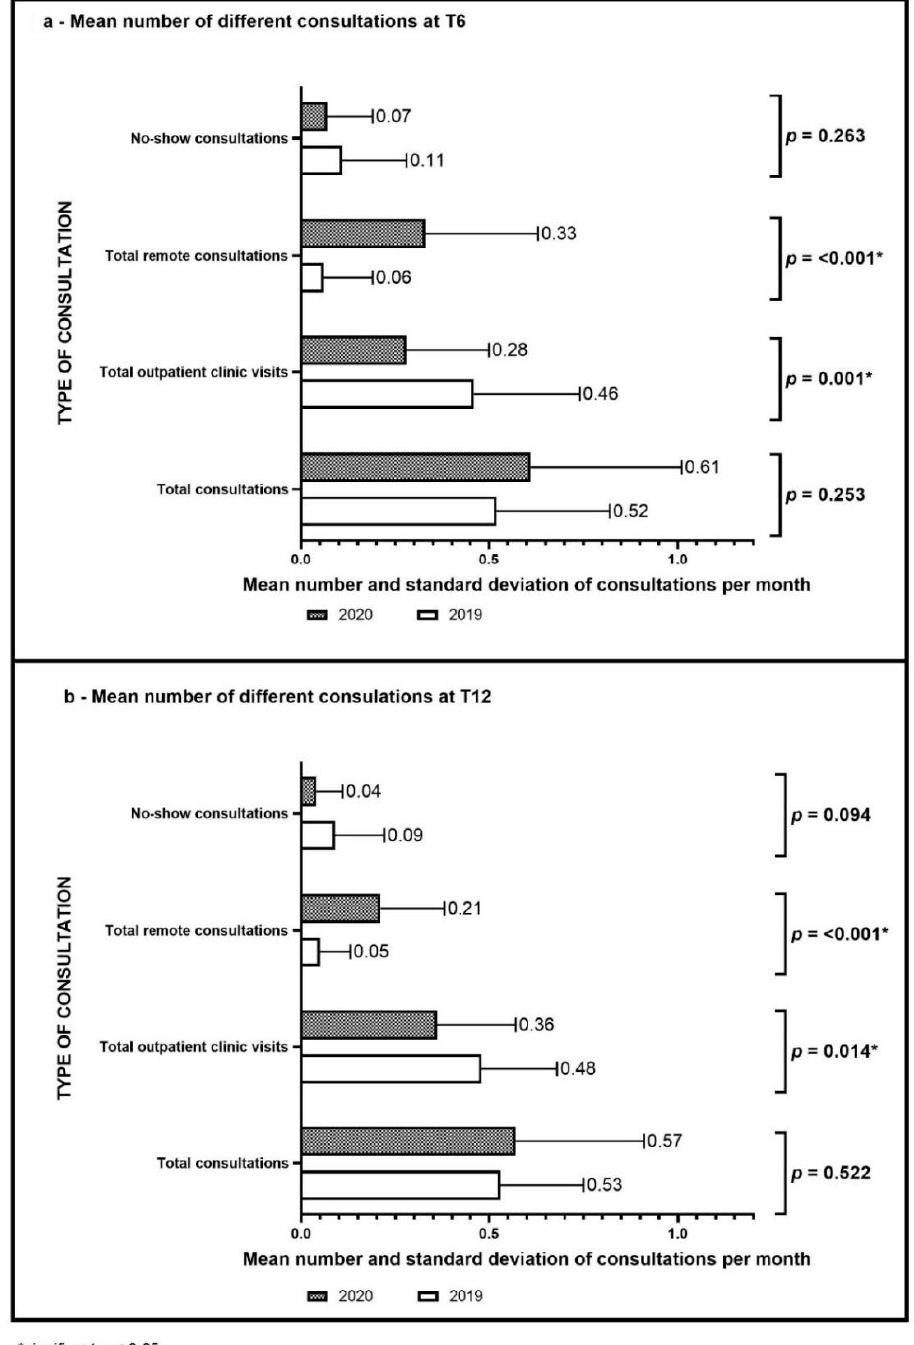
Figure 3. Characteristics of the lifestyle intervention: different consultations at T6 ( 3a ) and T12 ( 3b ) 2020 and in 2020 and 2019.